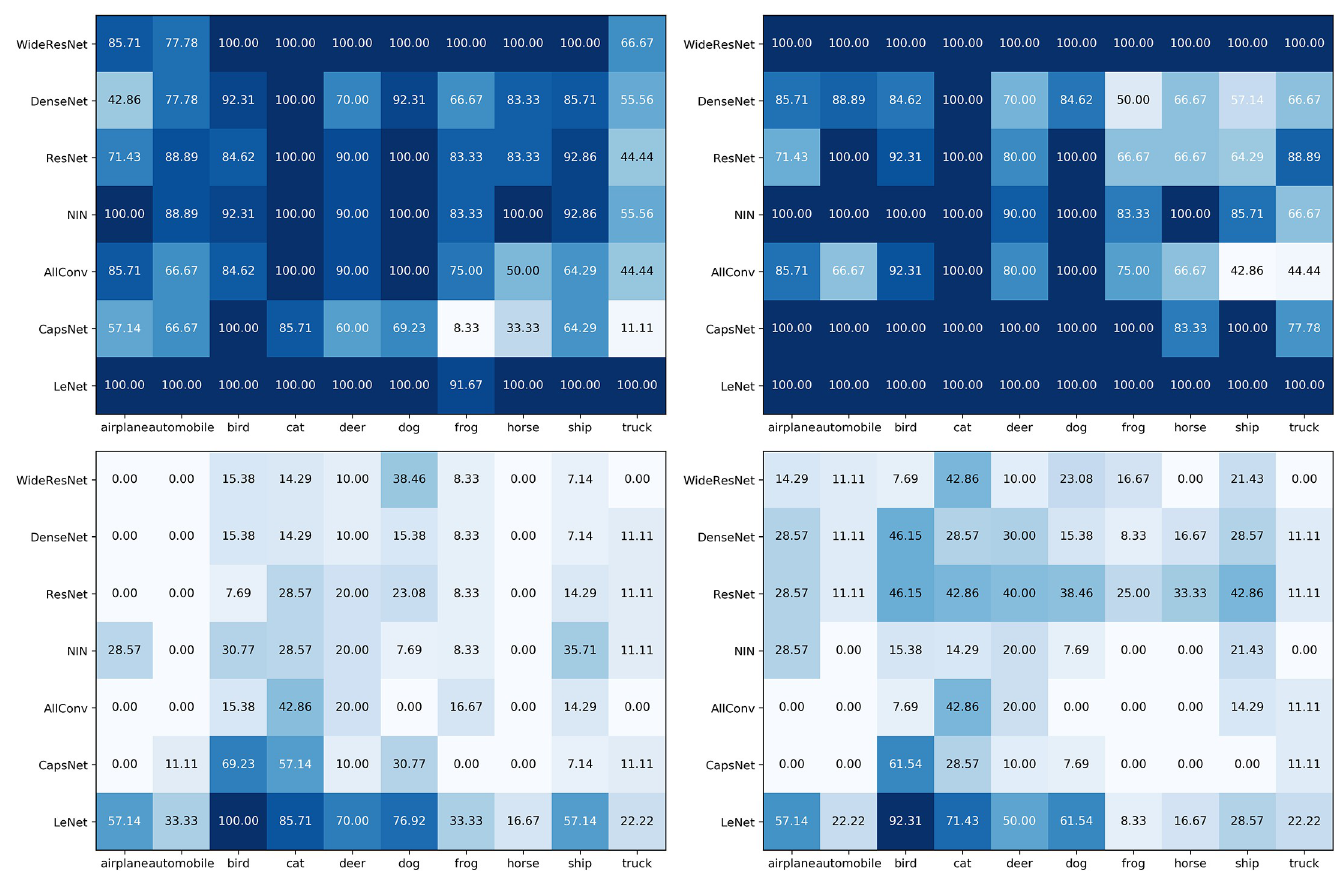
Fig 4. Adversarial accuracy from Table 5 across classes. The two diagrams at left and right are respectively L 0 and L 1 attacks. The top diagrams used th = 10 while the bottom ones used th =